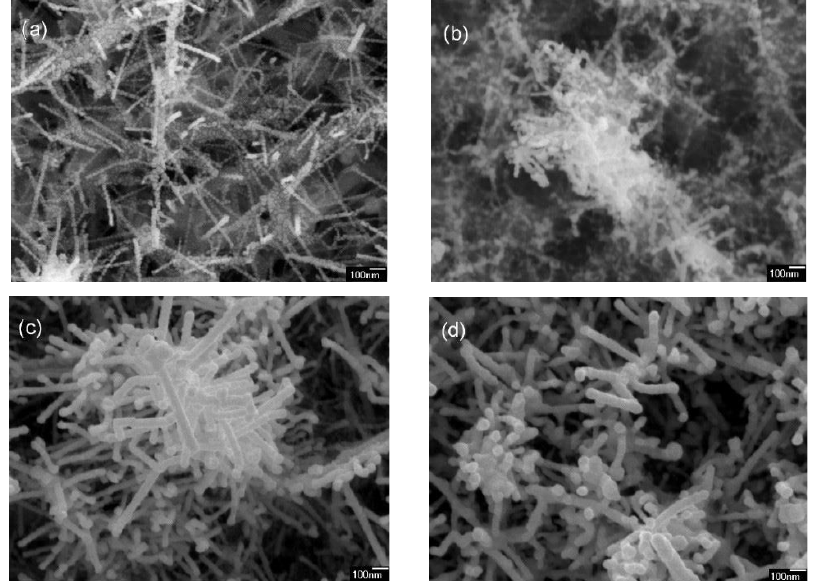
Figure 5. NTr nanostructure changes after immersion in water depending on Ag coating layer thickness: ( a ) 10 nm Ag layer dry [32], ( b ) 10 nm Ag layer after wetting, ( c ) 40 nm Ag layer dry and ( d ) 40 nm Ag layer after